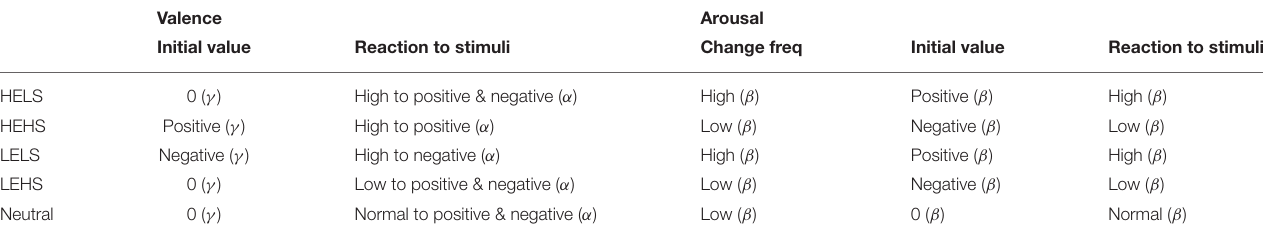
TABLE 1 | Based on empirical findings, five dimensions for the effect of personality parameters on the valence and arousal are defined (for emotional valence, initially experienced value of emotion, frequency of chance of valence and reaction to stimuli; and for emotional arousal, initial value and arousal change in response to positive and negative stimuli).